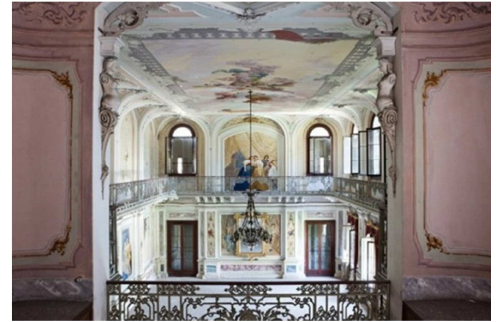
Figure 3: Upper view of the dance hall of Villa Bolasco.